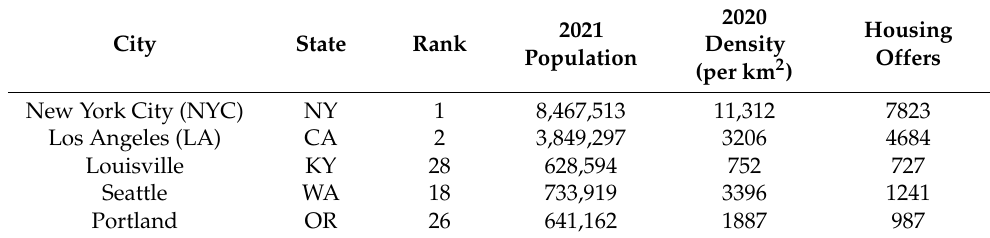
Table 1. U.S. Census population values and data set